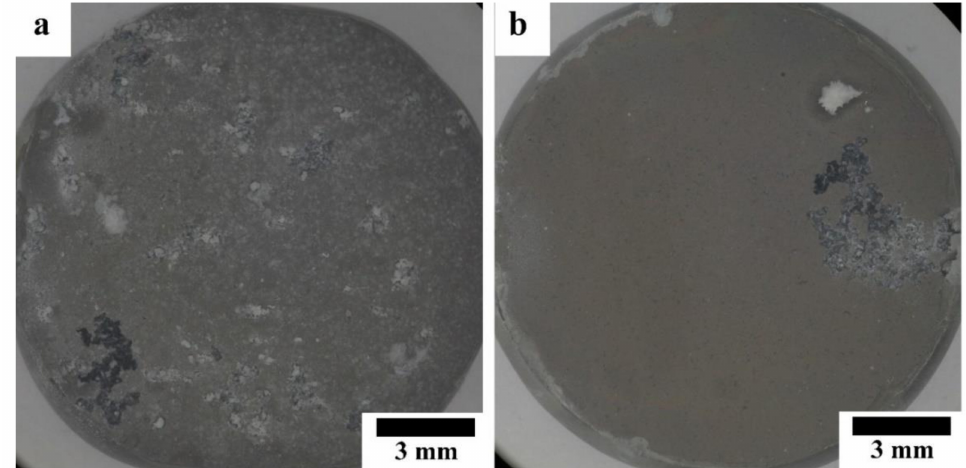
Figure 8. Morphology of HAp-coated composites after 14 days of immersion: ( a ) immersed HAp-coated Mg-10ZnO-10 min, ( b ) immersed HAp-coated Mg-10ZnO-2.5 h + 10 min.